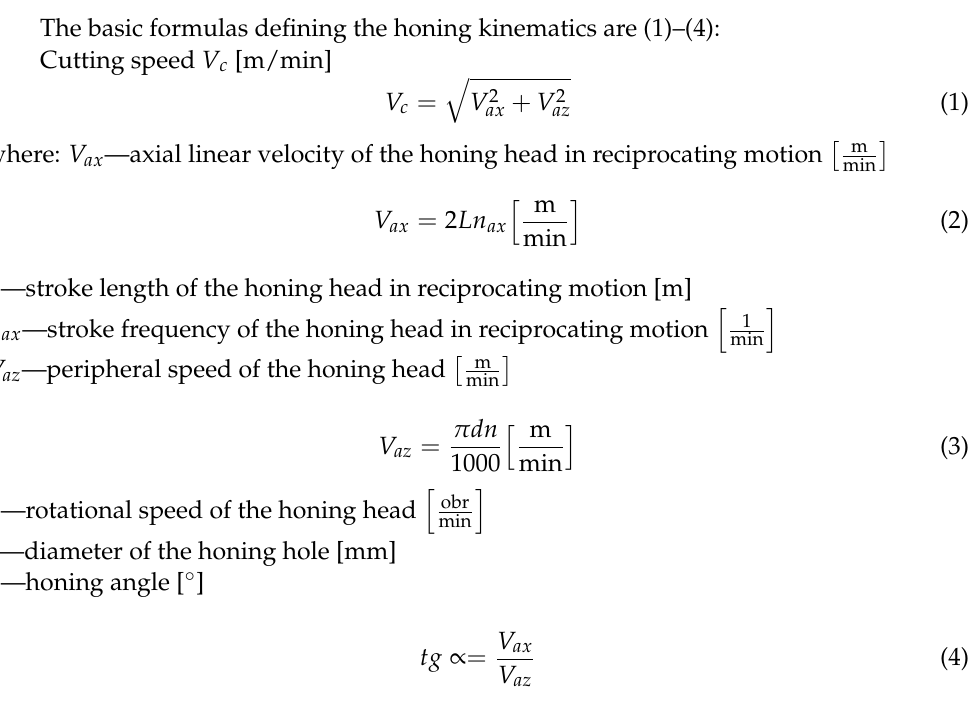
Figure 1. Structural diagram of honing of cylindrical holes: Vax—axial linear velocity of the honing head in reciprocating motion. Vaz—peripheral speed of the honing head, Vexp, expansion speed of the stones, 1—machined workpiece, 2—honing head, 3—expanding pin, 4–6—abrasive whetstone, [74]. Creative Commons (CC BY)